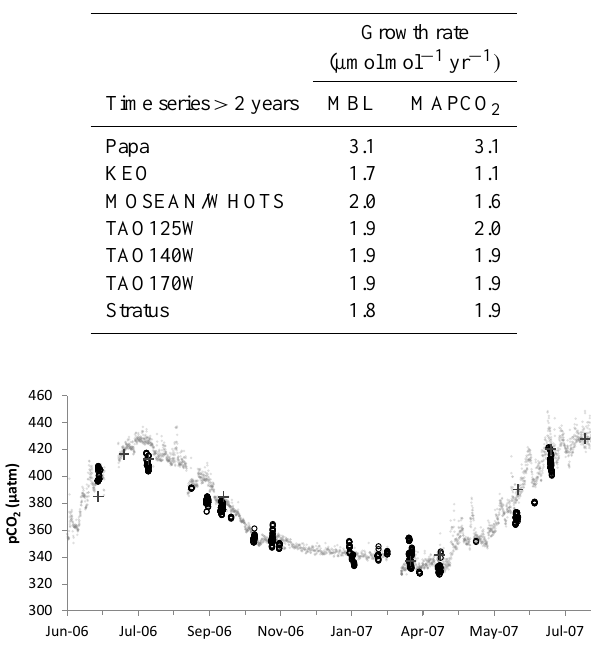
level values reported for the atmospheric comparison in Table 5 suggest strong statistical significance in the mean MAPCO 2 –MBL values.